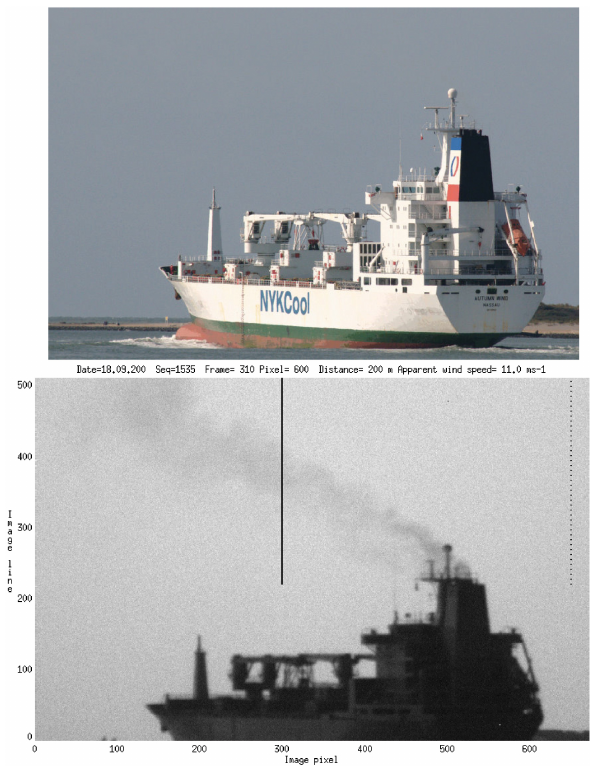
Fig. 10. Top: visible image of the NYK Cool (IMO 9038323). Bot- tom: UV image of the same ship. The black line shows the location of the vertical transect through the plume; the dashed line shows the location of the reference vertical profile.